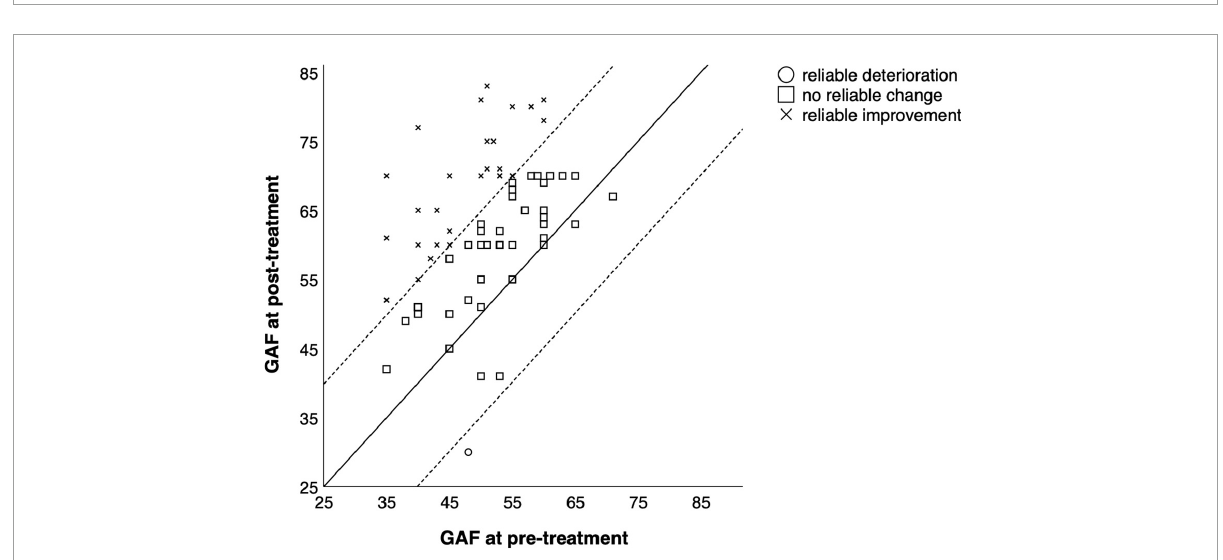
FIGURE4 Comparison of pre-treatment and post-treatment scores in the GAF for each participant. Reliable change index was calculated according to Jacobson and Truax